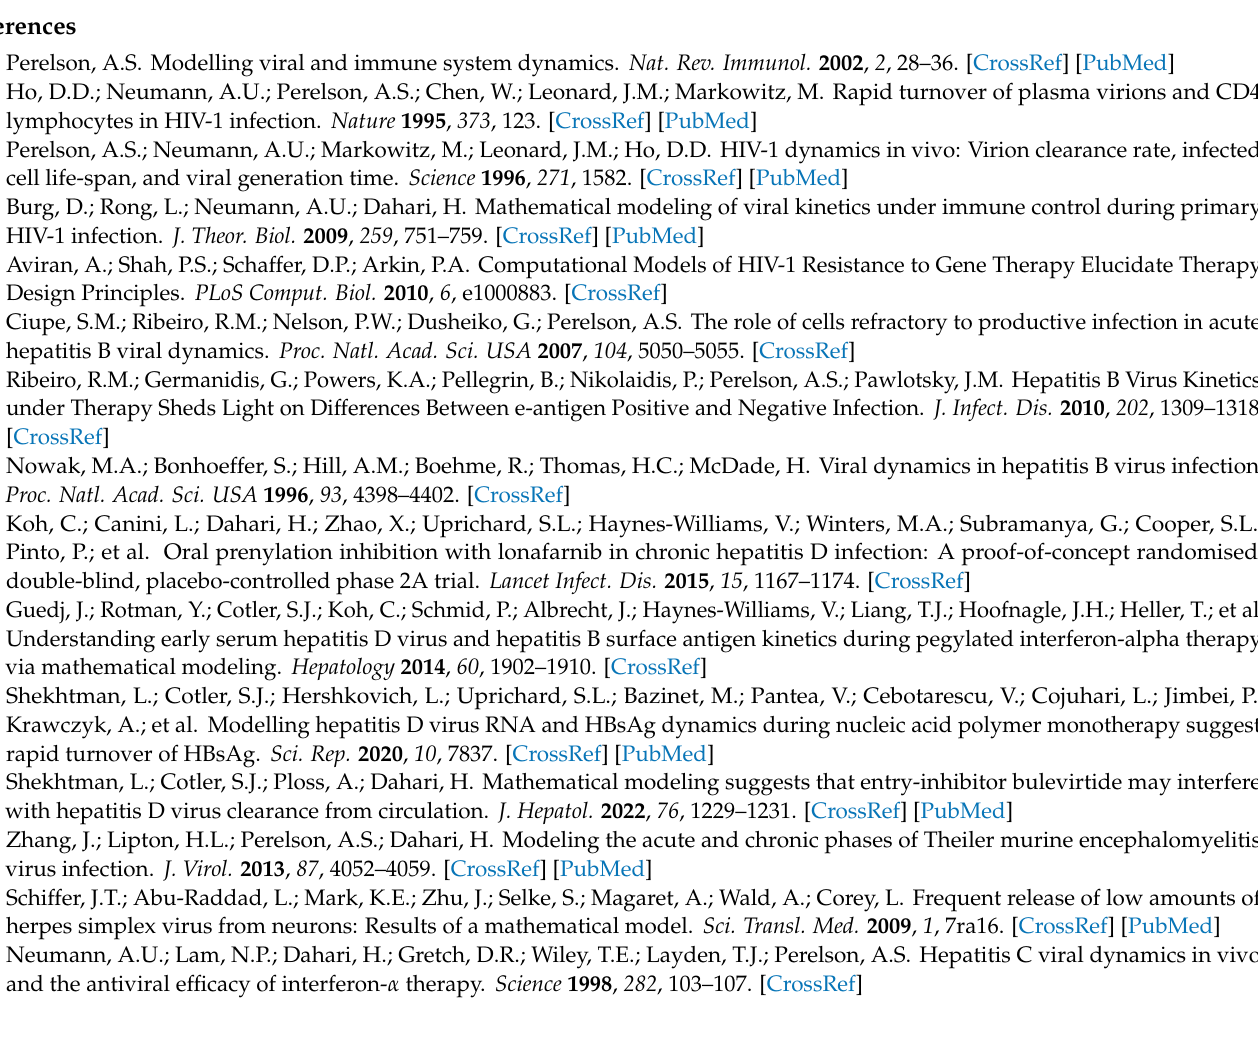
Figure A5. Influence of parameter s in the multiscale model on